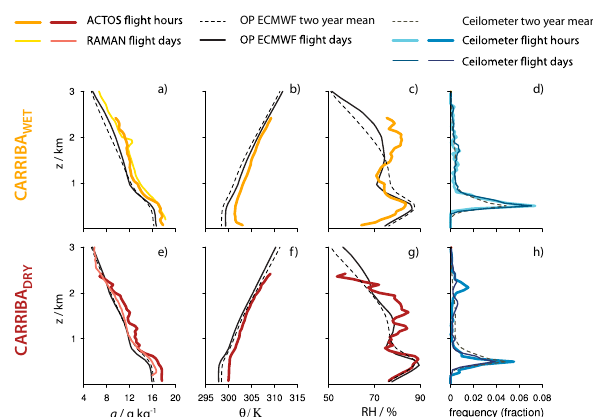
Fig. 5. Profiles of specific humidity q (a, e) , potential temperature θ (b, f) , relative humidity RH (c, g) , and the vertical distribution of cloud base heights (d, h) . Black dashed lines show the two year mean humidity and temperature profiles, derived from ECMWF op- erational analysis (12:00UTC) for a single grid point near Barba- dos, and two year of ceilometer-derived cloud base heights. The mean profiles during ACTOS flight days only are shown as black solid lines (EMCWF OP) and dark blue solid lines (ceilometer). The RAMAN lidar humidity profiles during 07:00–09:00UTC on ACTOS flight days are shown as yellow and rose. Profiles mea- sured by ACTOS are shown as thick orange and red lines, and the corresponding cloud base heights as thick light and dark blue lines. Top panels are for CARRIBA WET , bottom panels are the same, but for CARRIBA DRY